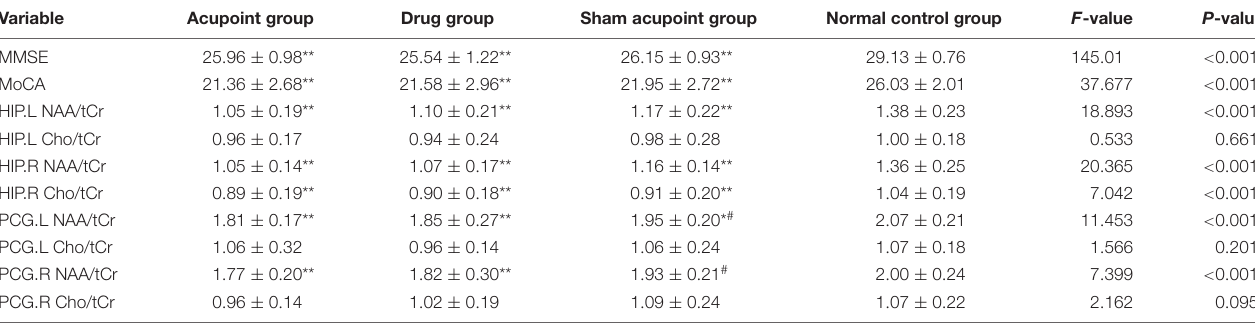
TABLE 2 | Cognitive scores and magnetic resonance spectroscopy (MRS) results before treatment.